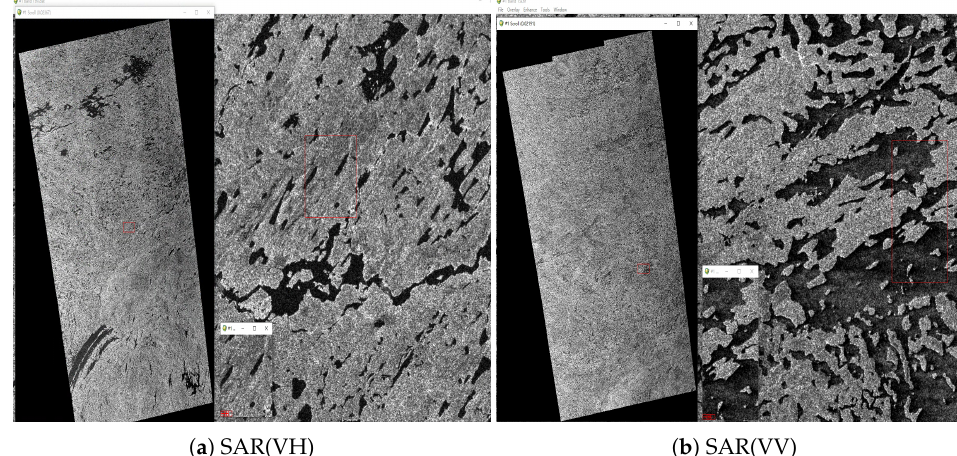
Figure 4. SAR Image Mosaic